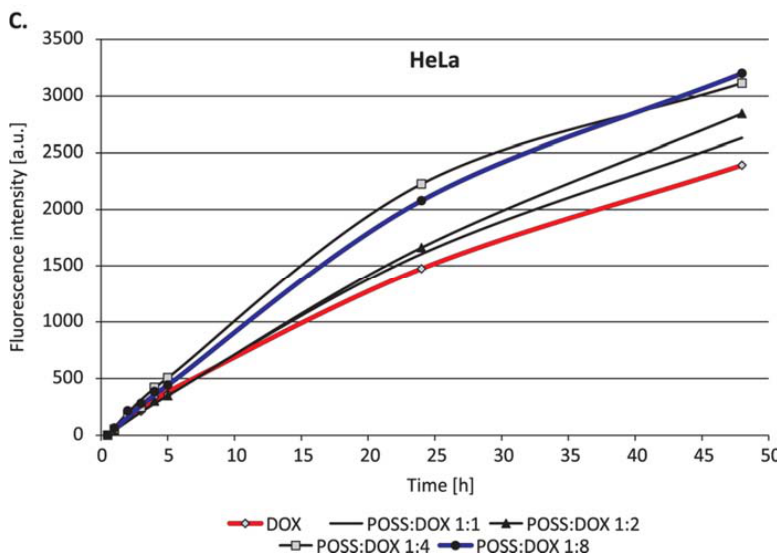
Figure 3. The cellular uptake of doxorubicin (1 μ M) and polyhedral oligomeric silsesquioxane co ‐ delivered at different molar ratios by ( A ) human breast adenocarcinoma (MCF ‐ 7), ( B ) microvascular endothelial (HMEC ‐ 1), and ( C ) human cervical cancer endothelial (HeLa) cell lines.